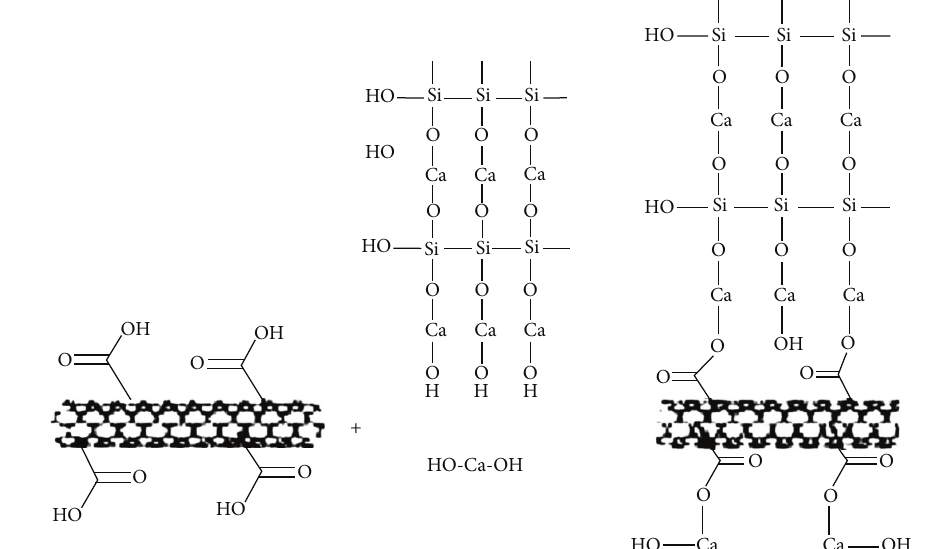
Figure 8: Reaction scheme between carboxylated nanotube and hydrated production (Ca(OH) 2 and C-S-H) of cement [16].